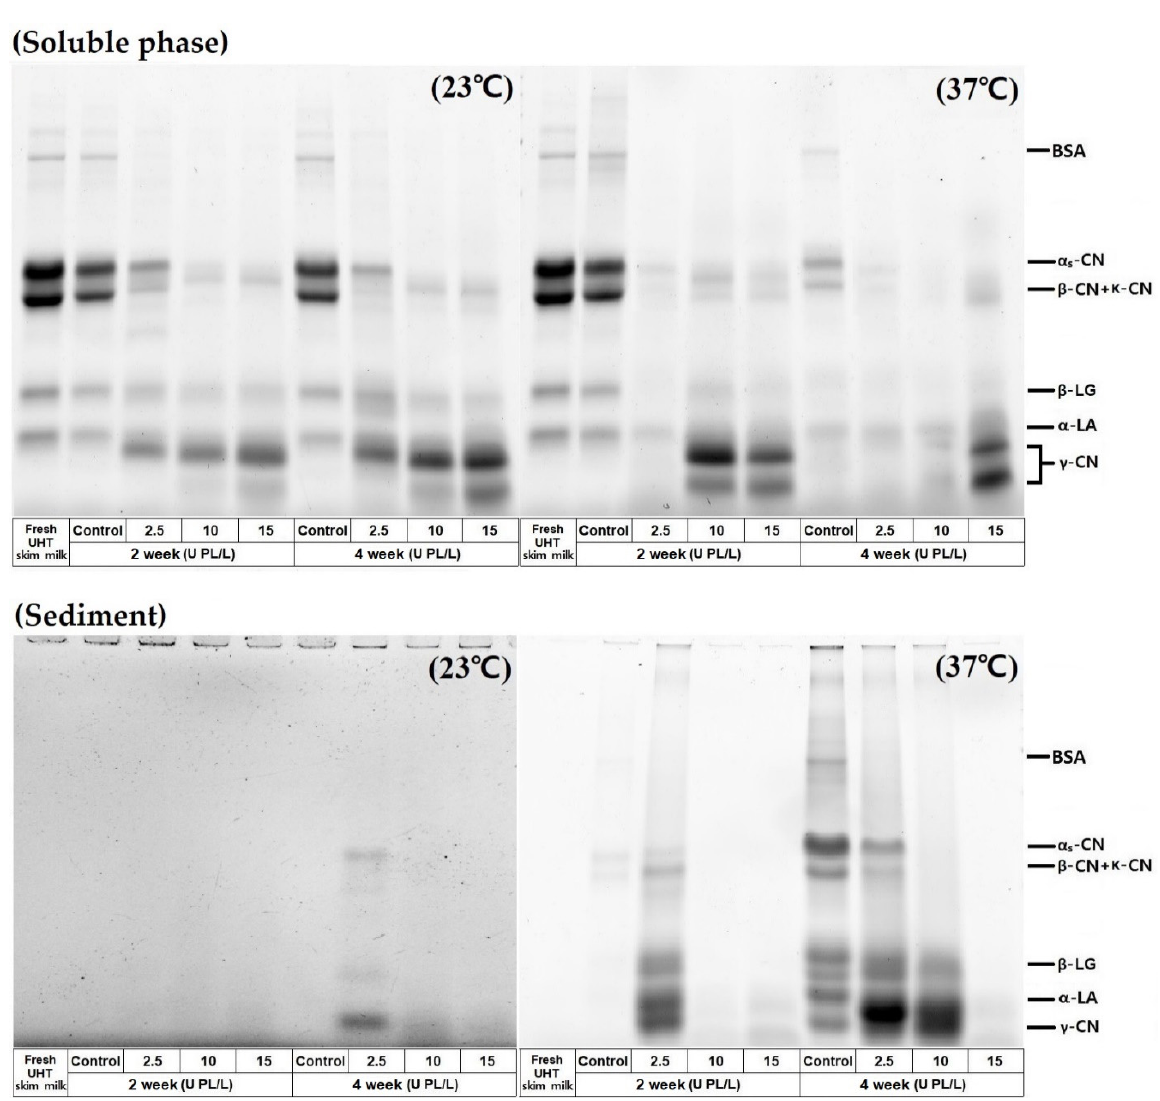
Figure 4. SDS-PAGE protein profiles of soluble and sediment phase of UHT skim milk containing 2.5, 10, and 15 U PL/L stored at 23 °C and 37 °C for up to four weeks. The sediment produced during storage was obtained by centrifugation (27,000× g ) at 4 °C for 10 min and redispersed in distilled water by sonication. UHT, ultra-high temperature; PL, plasmin; BSA, bovine serum albumin; CN, casein; β -LG, β -lactoglobulin; α -LA, α -lactalbumin.